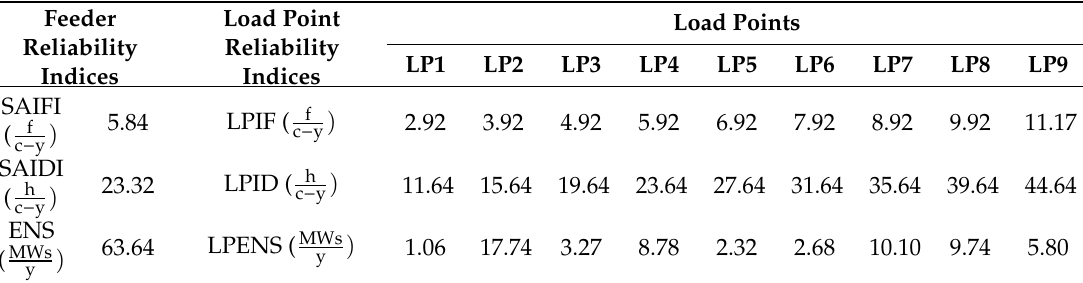
Table 2. Calculated reliability indices for Case-1.